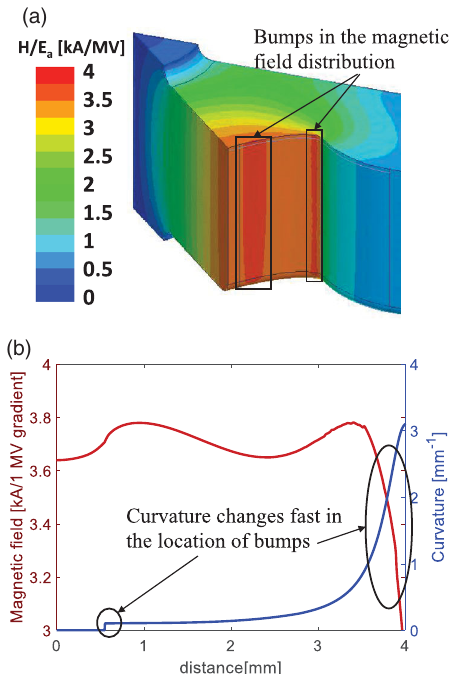
FIG. 5. (a) Magnetic field distribution in the middle cell of CLIC baseline accelerating structure ( 1 = 8 view); (b) curvature of the wall